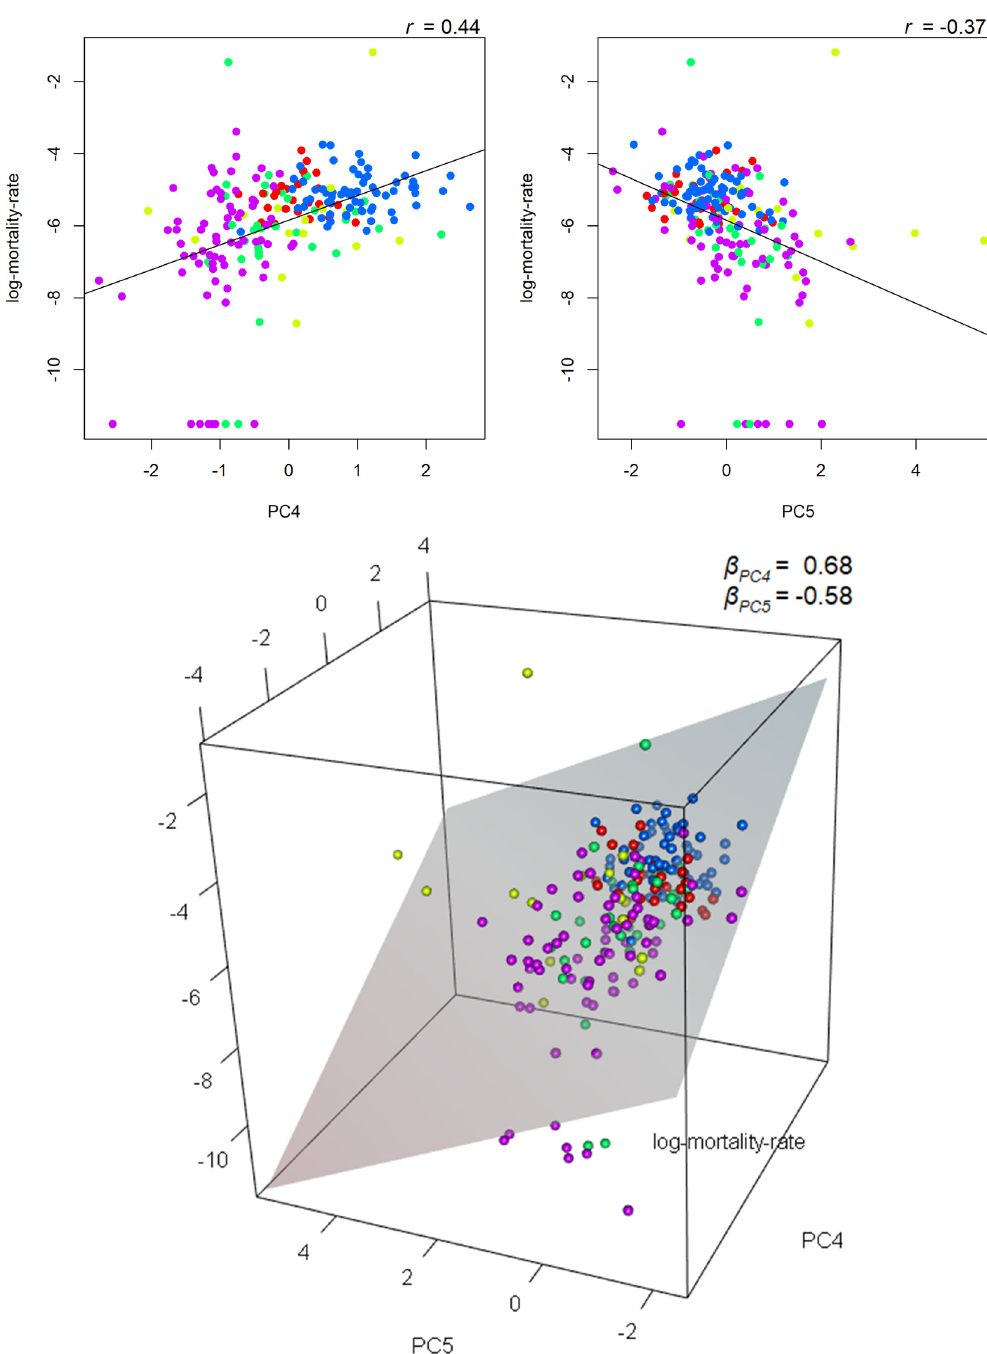
Figure A2. Relationships between principal component scores and log-mortality-rate. Note: The diagonal panels show the histograms of the principal components scores and log-mortality-rate; The lower panels show the scatterplots of the cor- responding variables; The upper panels show correlation coefficients where the font size is proportional to the magnitude of the correlation coefficient.